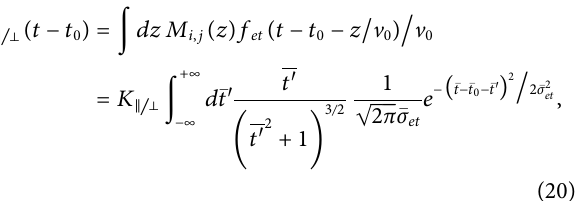
with the parameter (cid:2) σ et (cid:1) σ et / t r being the ratio of the wavepacket duration and the transit time K (cid:4) / ⊥ (cid:1) e 2 r i,j · ^ e z / r /4 π ϵ 0 r 2 ⊥ shows the weighed interaction strength (20) between the TLS and free-electron for the longitudinal and vertical dipole moment orientations with different electron wavepacket sizes quanti fi ed by parameter (cid:2) σ et . The maximum interaction strength decreases with the increase of the wavepacket size. The longitudinal component of the electric fi eld induced by the traversing electron at the position of the dipole reverses the sign. This is the reason for the antisymmetric